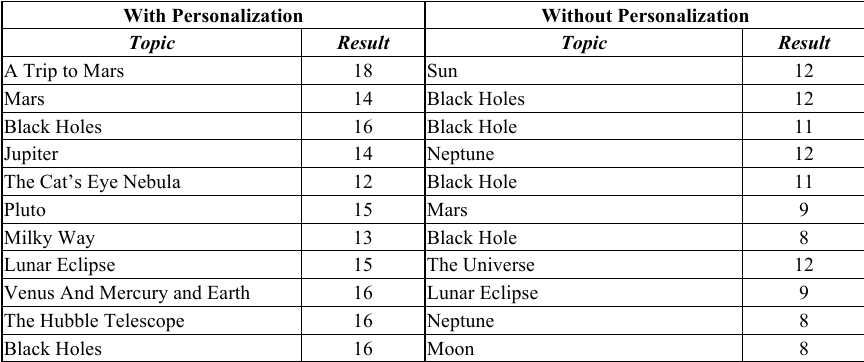
Table 3. Conceptual knowledge assessment results